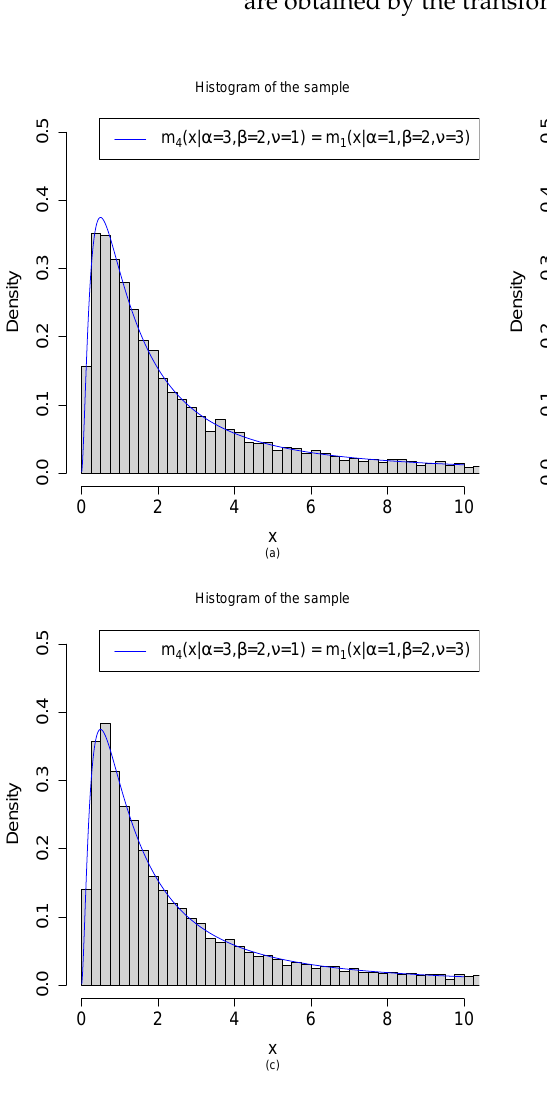
Figure 8. Random variable generations from m 4 ( x | α = 3, β = 2, ν = 1 ) = m 1 ( x | α = 1, β = 2, ν = 3 ) by three methods with α = 3, β = 2, and ν = 1. ( a ) x i ( i = 1, . . . , n ) are iid from IG − (cid:102) IG . ( b ) x i ( i = 1, . . . , n ) are iid from (cid:102) IG − (cid:101) G . ( c ) x i = ( 1/ z i − 1 ) / β , where z i are iid from Beta ( ν , α ) for i = 1, . . . , n